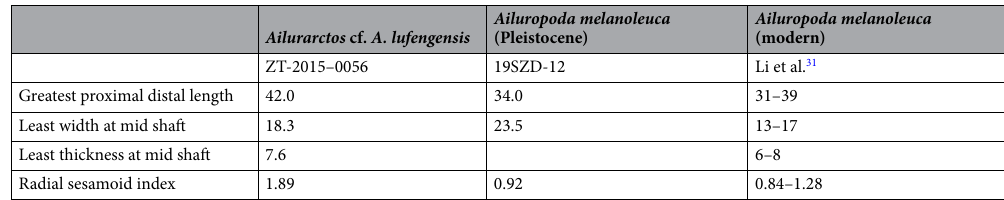
Table 2. Measurements of radial sesamoids (in mm). Radial sesamoid index is bone length/M2 length (the latter from Table 1 as a proxy for body size). This shows the size of the false thumb relative to body size. Radial sesamoid data for a late Pleistocene Ailuropoda melanoleuca from Shuanghe Cave is from Wang et al. 12 ; average M2 length for 12 individuals from this cave (36.87 mm) kindly provided by Qigao Jiangzuo. Note that for Ailuropoda melanoleuca , we used the radial sesamoid length range in Li and others 31 divided by M2 length range from Colbert and Hooijer 50 , and the resulting radial sesamoid index range reflects the likely values that would exceed actual ratios if derived from individual